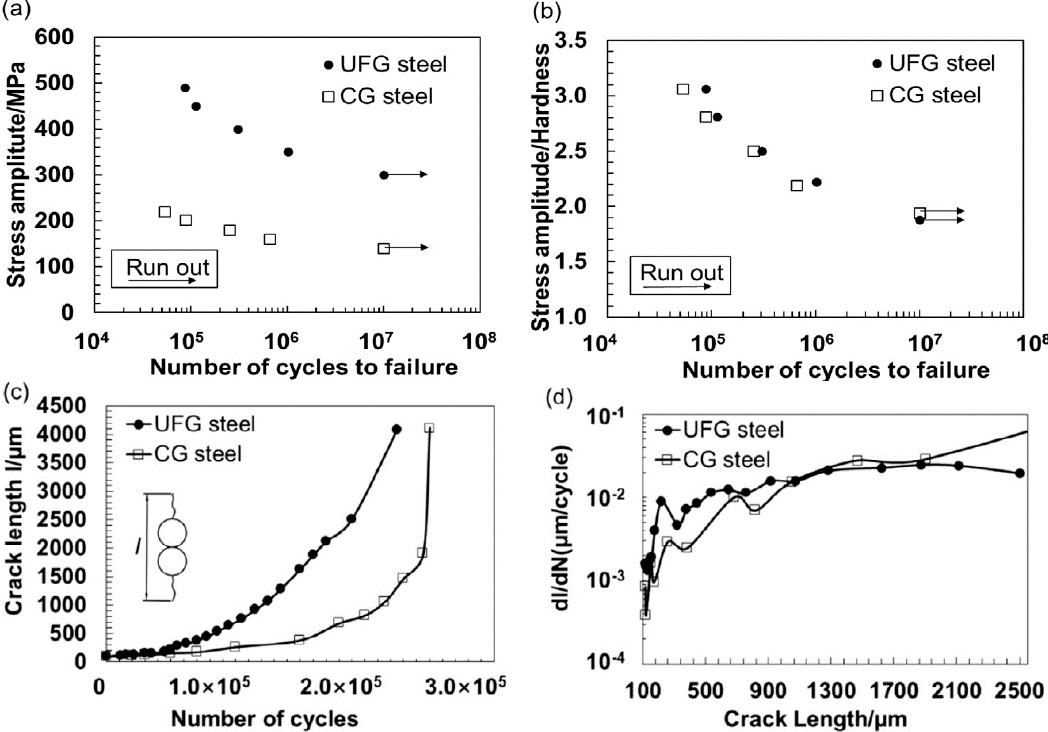
Figure 22. Up, ( a ) S-N curves of CG and UFG steels. ( b ) Number of cycles to failure plotted against stress amplitude normalized by hardness [138]; bottom, FCGR curves of the two steels at the same ratio between stress amplitude and hardness. ( c ) Crack length versus the number of cycles. ( d ) Crack growth rate versus crack length [138].